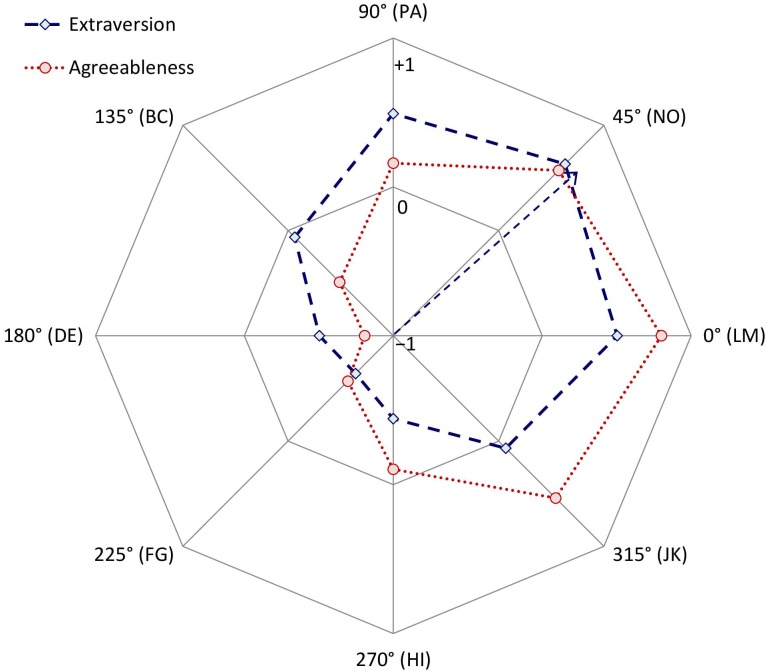
Correlations between collective Agreeableness or Extraversion and each Circumplex Team Scan octant scale. Within each octant, correlations could range from a minimum of –1 (at the circle’s midpoint) to a maximum of +1 (at the circumference). The arrow shows the vector sum of the Extraversion correlations.